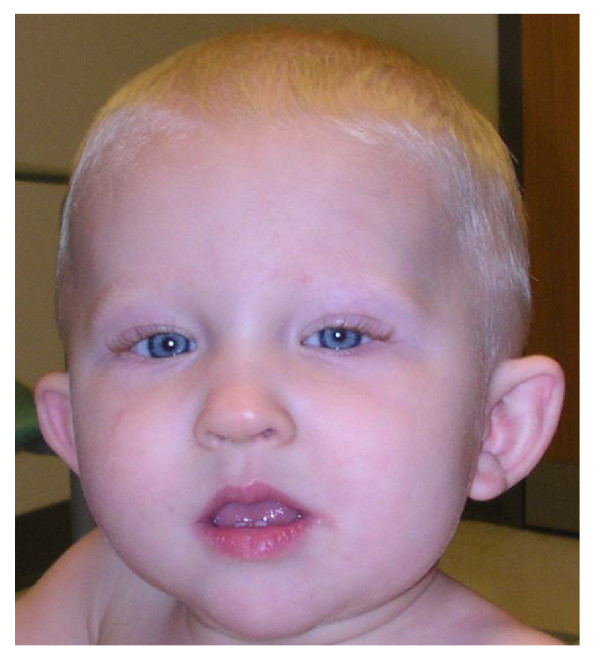
Proband at age 15 months. Note triangular-shaped face, mild ptosis on the left side, and cupped, posteriorly rotated ears.